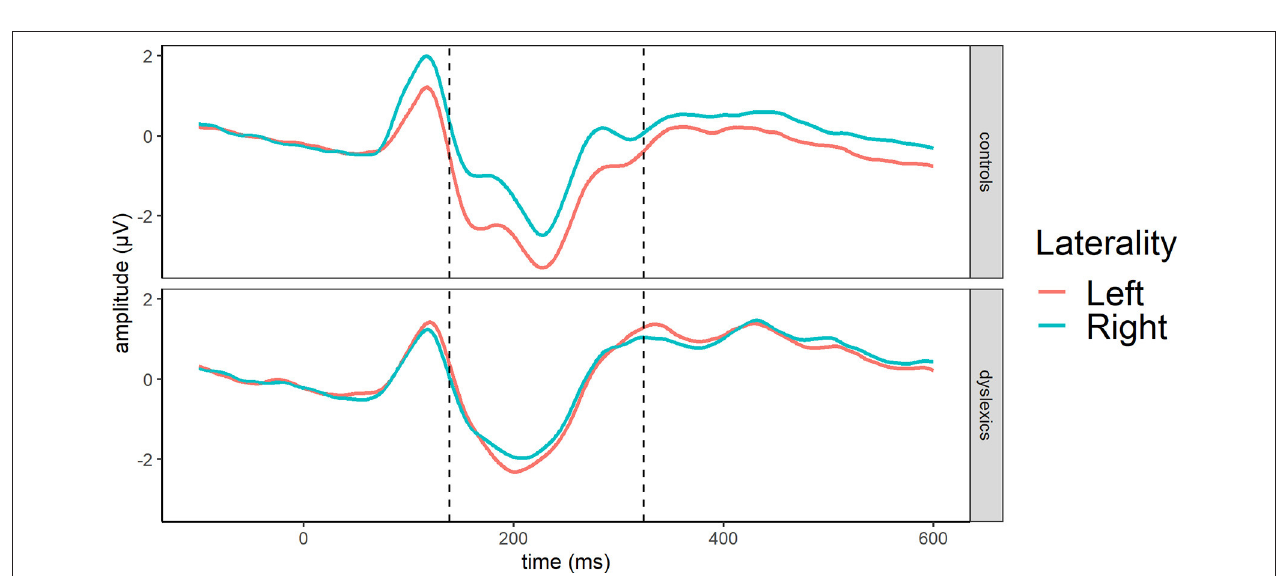
FIGURE 4 | Averages across occipito-temporal electrodes (O1, O2, P7, P8) for N1 in reference stimuli showing group and laterality interaction at GFP-based N1 segment (dashed line): 139–324ms.